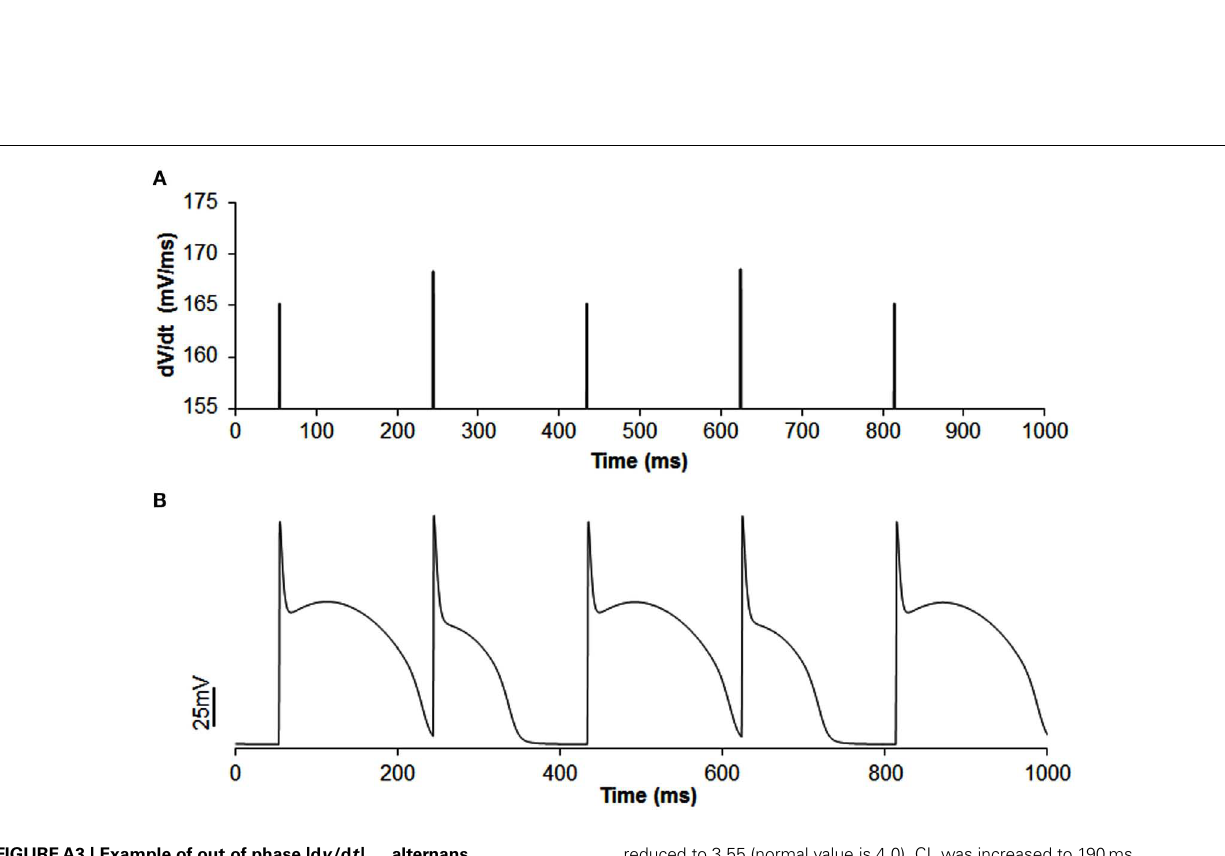
reduced to 3.55 (normal value is 4.0). CL was increased to 190ms instead of 169ms as decreasing [K + ] o increased APD and blocked the short beat at CL of 169ms.The amplitude of |d v /d t | max alternans is 1.75%.